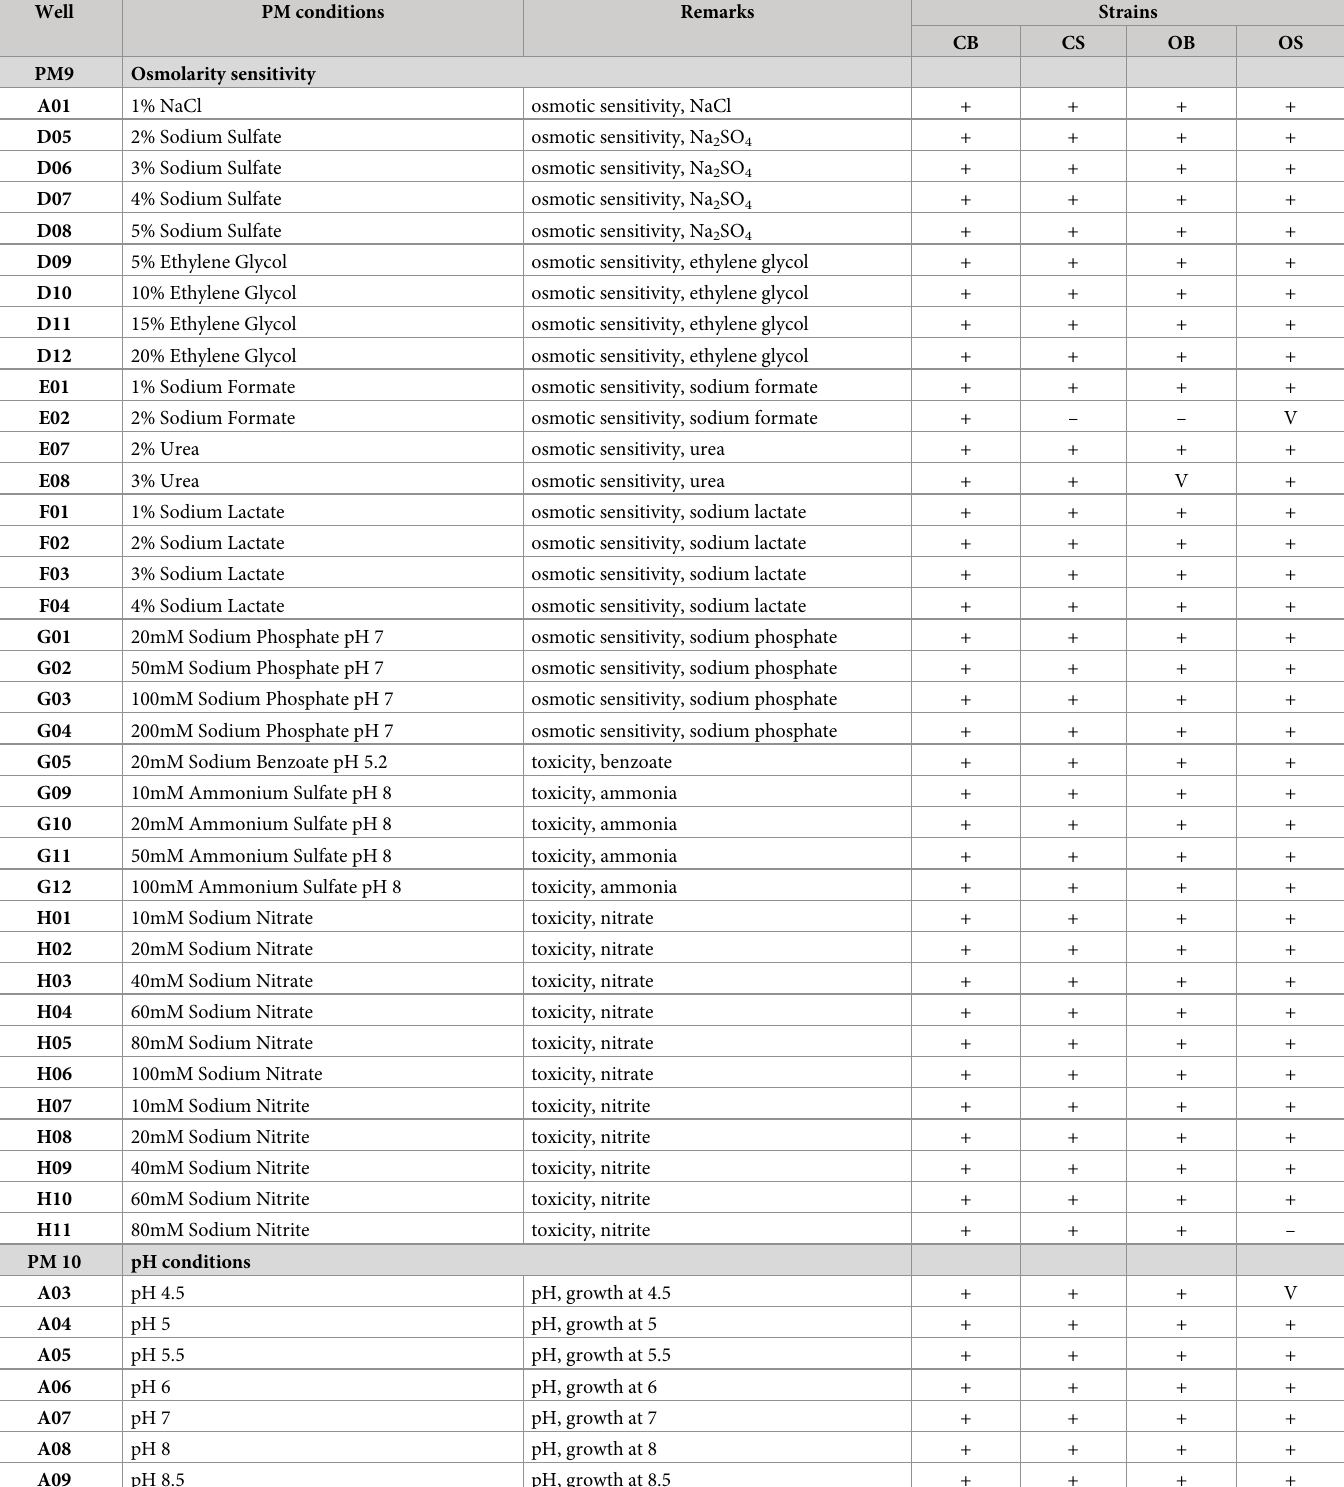
Table 7. Phenotype microarray results for PM9 and PM10.